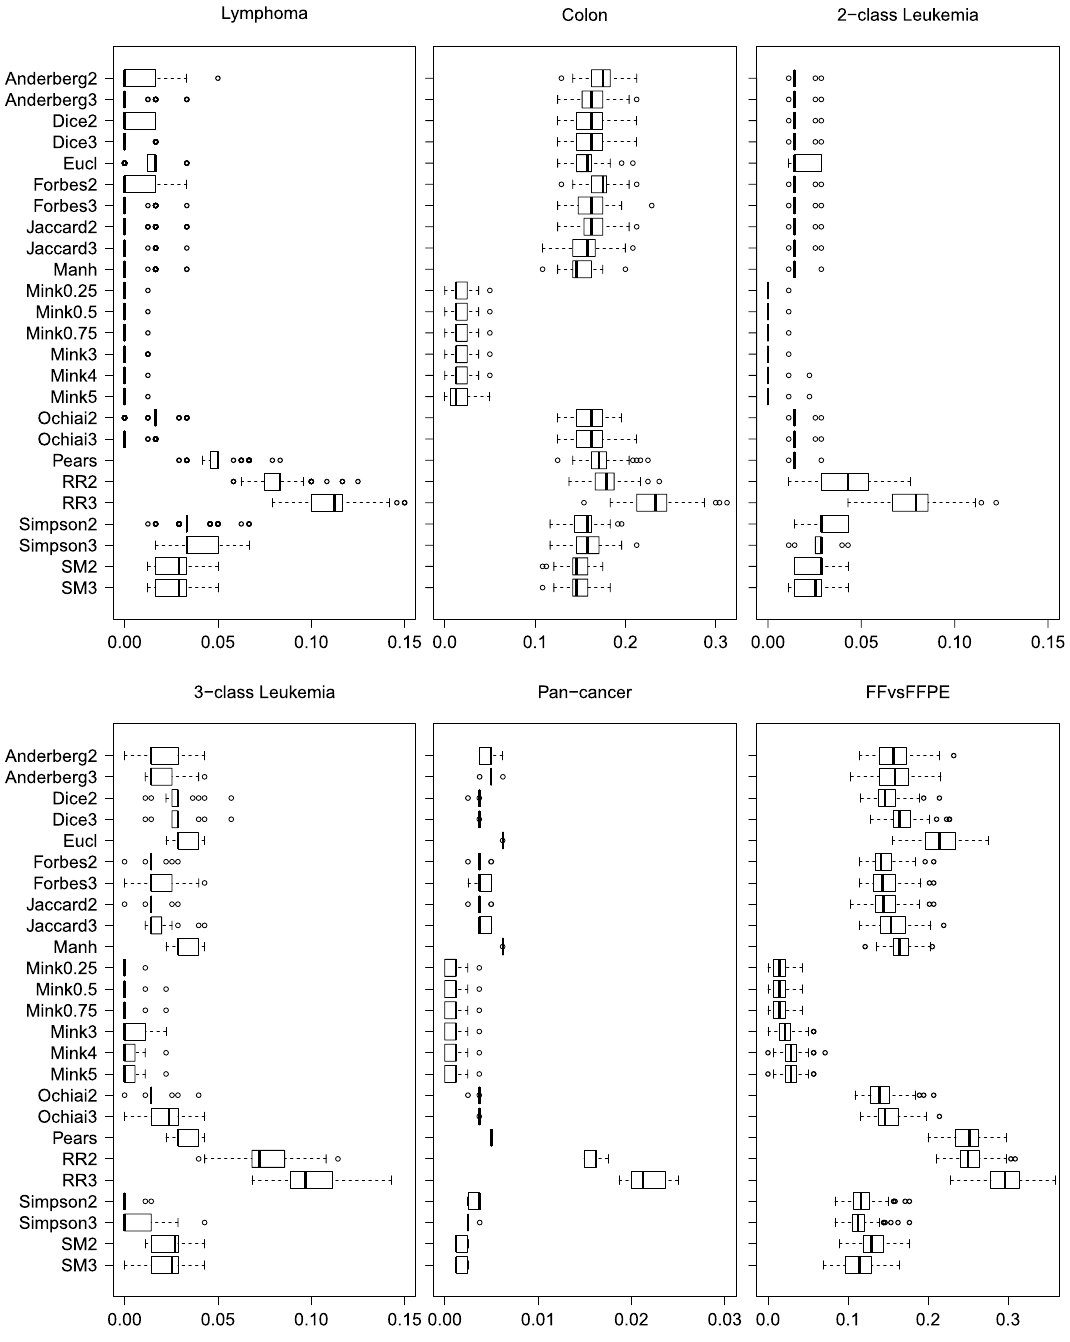
Figure 4. Classification error rates in real data sets. Distribution of kNN classification error rates for the lymphoma (top left), colon (top middle), leukemia with two (top right) and three classes (bottom left), RNAseq storage conditions (bottom middle) and pan-cancer (bottom right) data sets, using 10-folds cross-validation, with selection-bias